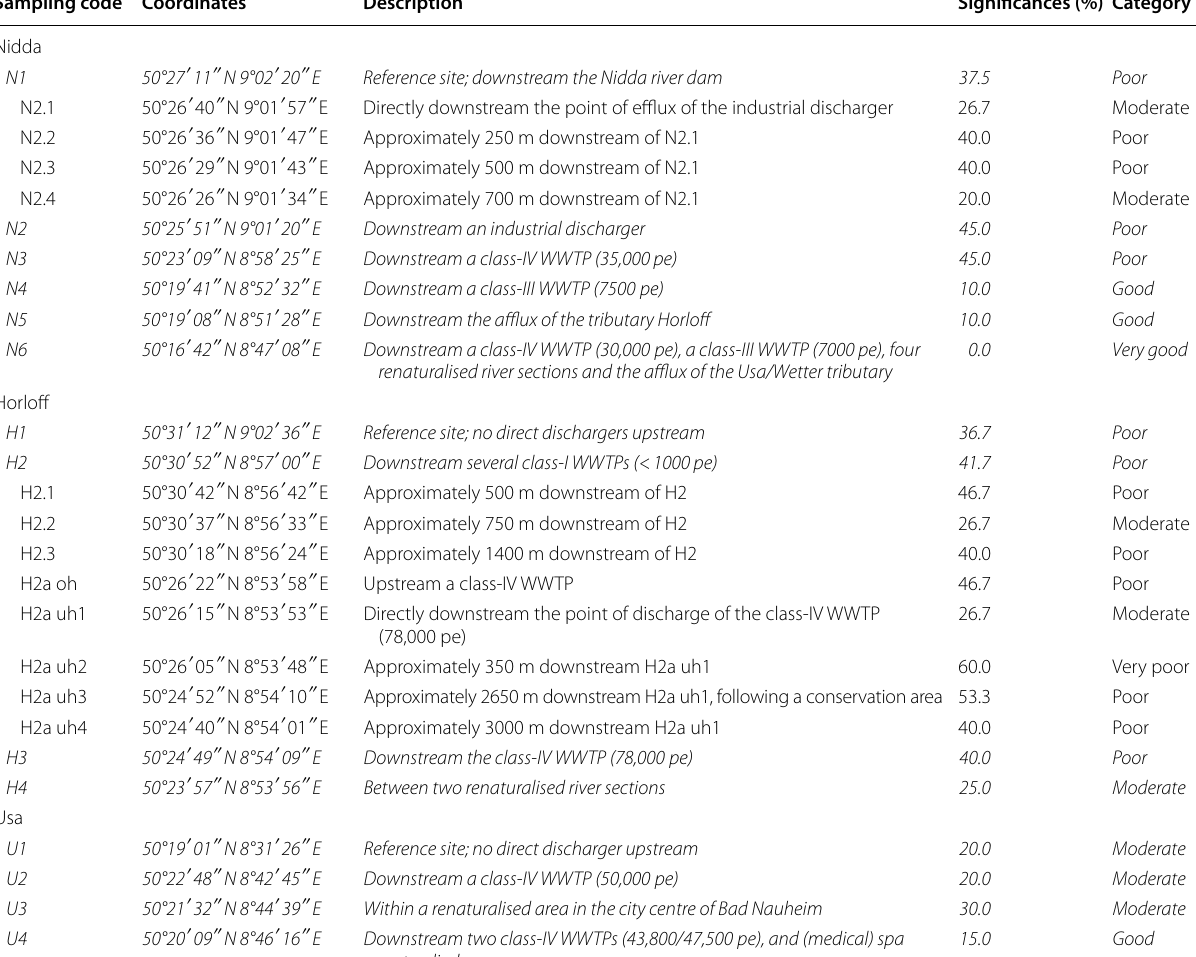
Table 1 Overview of sampling sites in the Nidda catchment area, including the evaluation based on obtained